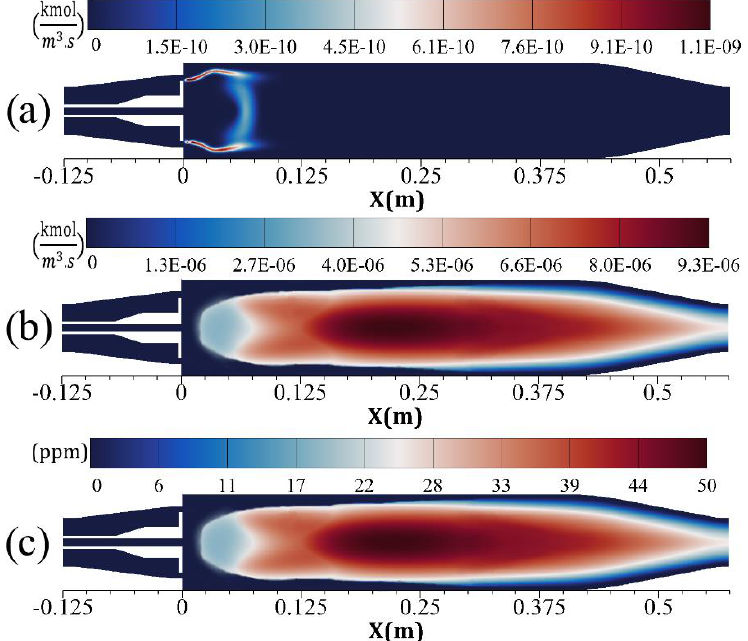
Figure 8. Formation rates of ( a ) prompt NO, and ( b ) thermal NO, and ( c ) concentration of NO in model combustor (mid-plane, Z = 0). model combustor (mid-plane, Z =